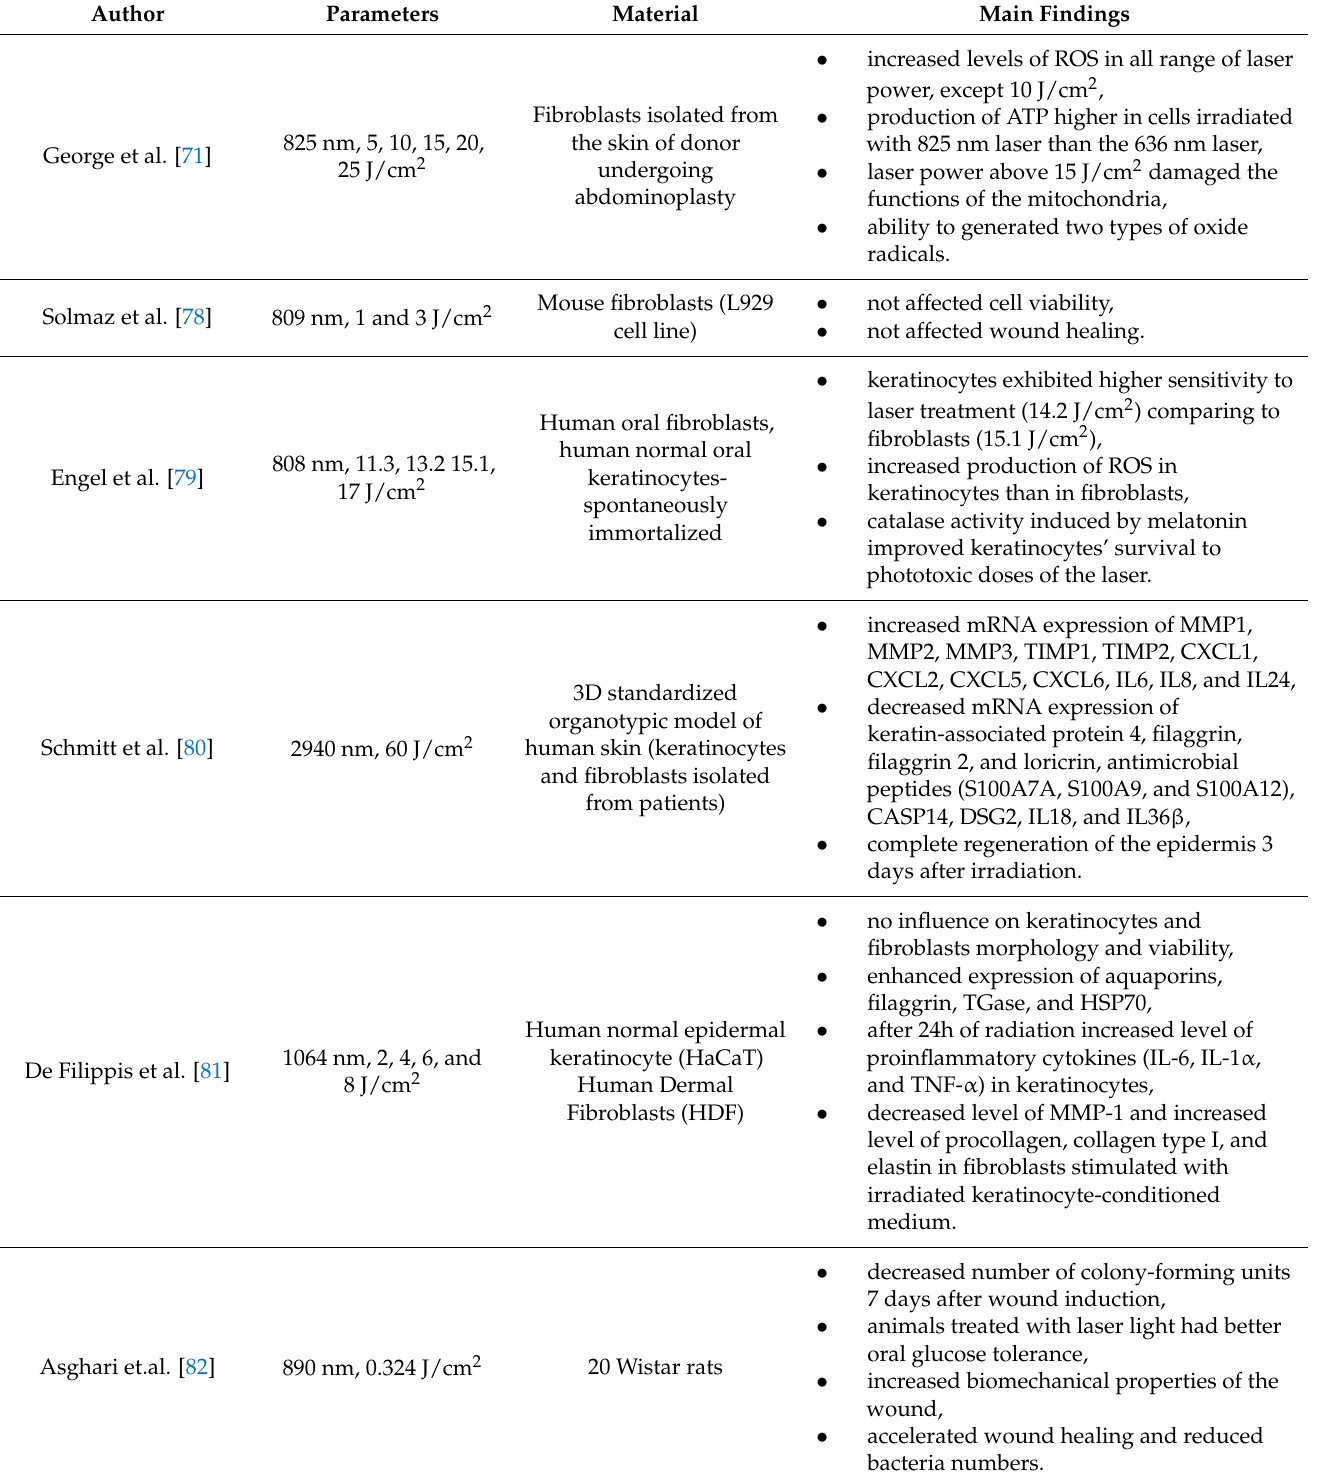
Table 5. IR light (780 nm–1mm) effects on skin